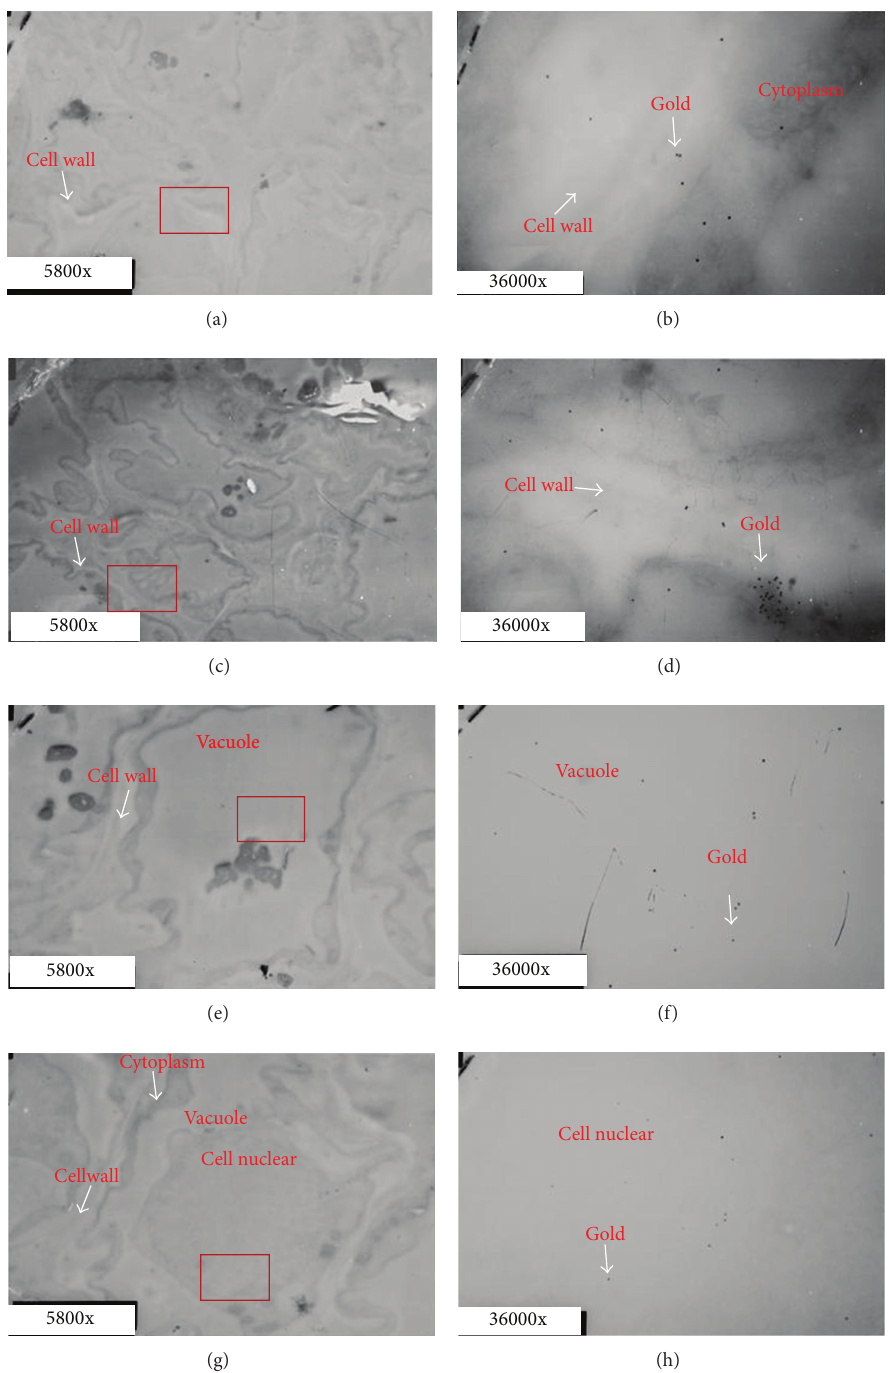
Figure 7: Transmission electron micrographs of tomato pedicel and localization of polygalacturonase (PG) in abscission zone cells by immunogold labeling (proximal end, 24 h). (a) and (b): cortex; (c) and (d): vascular region; (e) and (f): vacuole; (g) and (h): cell nucleus; (b), (d), (f), and (h) are enlarged photos for the rectangles region in (a), (c), (e), and (g),